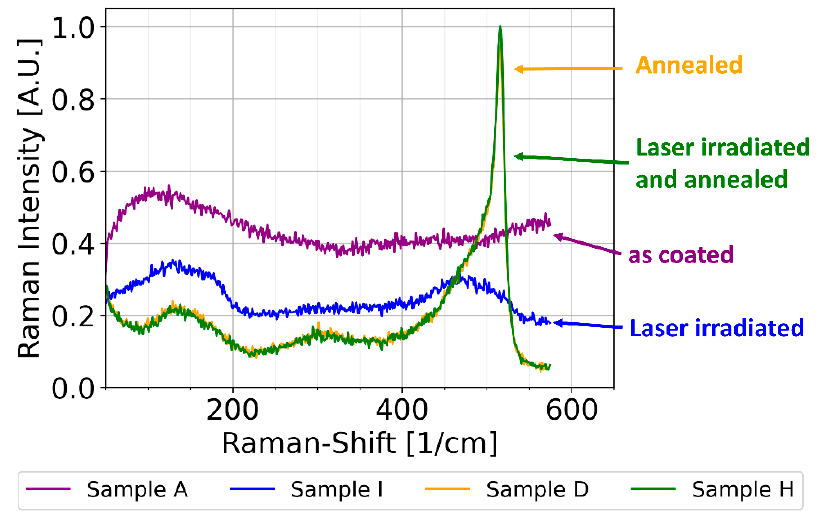
Figure 6. Raman measurements of different SiO x samples. Prior to the high-temperature annealing, an unspecific signal is present (sample “A”). Laser treatment causes a shallow, broad peak around 470 cm − 1 (sample “I”). The high-temperature annealing (1050 °C) results in a sharp peak at 515 cm − 1 , while there is no difference in Raman signals between laser-processed and unprocessed samples (samples “D” and “H”). The measurements of the substrate have been subtracted.